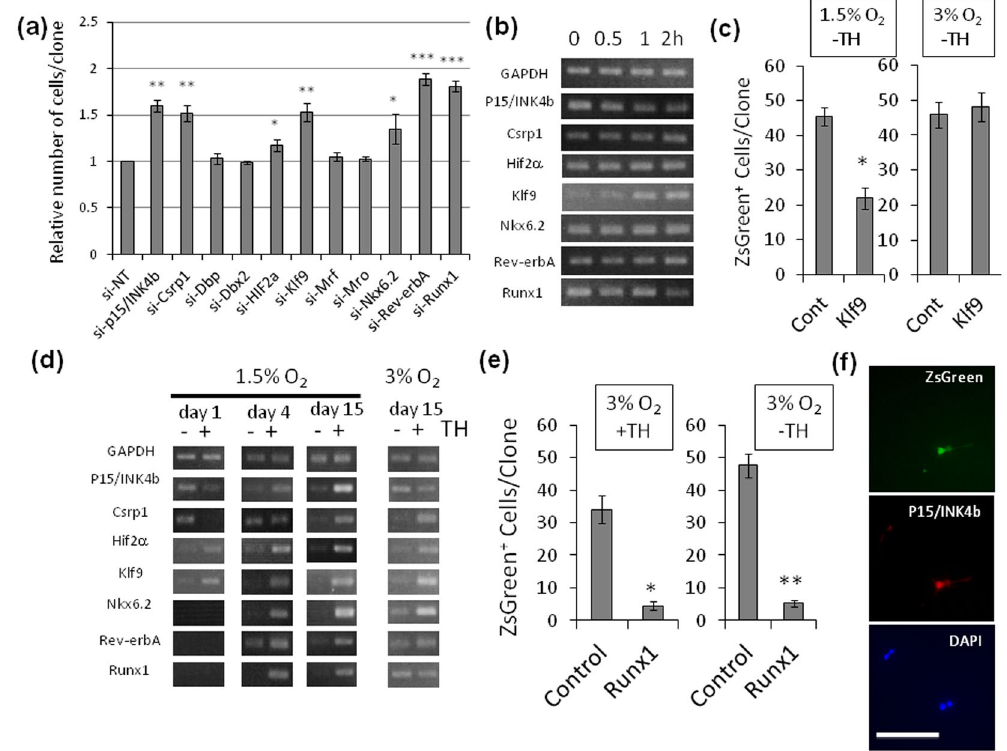
Figure 5. Runx1 dictates the cell cycle deceleration of OPCs in hypoxia. ( a ) P7 rat OPCs were cultured without TH in 1.5% O 2 conditions for 12 days, then the cells were co-transfected with anti-p15/INK4b siRNA (si-p15/ INK4b) or siRNA against the gene of each transcription factor and pMaxGFP. Cells were cultured with TH in 1.5% O 2 conditions for another 4 days. The number of GFP + cells in each clone was counted. Data was normalized against the average number of negative control (cells transfected with non-target siRNA; si-NT). * P < 0.05, ** P < 0.01, *** P < 0.001 (unpaired Student’s t -test, n = 3). ( b ) To investigate the immediate early responses of the genes of the deceleration of cell cycle related transcription factors, P7 rat OPCs cultured without TH for 10 days in 1.5% O 2 were pre-treated with cycloheximide (50 μ g/ml) for 6 hours, after then TH was added to the medium. Cells were harvested at 0, 0.5, 1 and 2 hours later. RT-PCR assay was carried out. GAPDH was used as a negative control. ( c ) P7 rat OPCs were infected with retrovirus vector Klf9-IRES- ZsGreen and were cultured for 7 days without TH in 1.5% or 3% O 2 conditions. Cont; empty vector RetroX- IRES-ZsGreen1 infected OPCs, Klf9; Klf9 over expressing cells. * P < 0.001 (unpaired Student’s t -test, n = 3). ( d ) P7 rat OPCs cultured with ( + ) or without TH ( − ) in 1.5% O 2 for 1, 4 and 15 days, or in 3% O 2 for 15 days. Then RT-PCR assay was carried out. GAPDH was used as an internal control. ( e ) Freshly prepared P7 OPCs were cultured without TH in 3% O 2 conditions overnight. Then cells were infected with Runx1 (Runx1b-IRES- ZsGreen) over-expressing retrovirus vector (Runx1) or ZsGreen expressing empty vector (Control). Cells were cultured for 7 days with or without TH in 3% O 2 . The number of ZsGreen + cells in each clone was counted. * P < 0.005, ** P < 0.001 (unpaired Student’s t -test, n = 3). ( f ) OPCs overexpressing Runx1 ( green ) in (d) were stained with the nuclear stain DAPI ( blue ) and rabbit anti-p15/INK4b antibodies ( red ). Scale bar: 100 μ